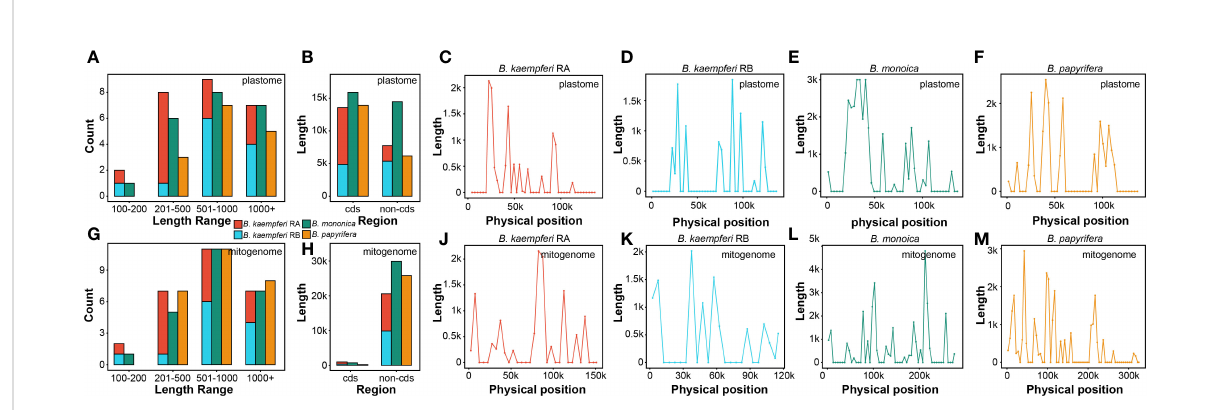
FIGURE 4 Transferred fragments from plastome to mitogenome across the three Broussonetia spp. in this study. (A) Length distribution of transferred fragments in plastome. (B) Type of transferred fragments in plastome. (C) Length distribution of transferred fragments in mitogenome. (D) Type of transferred fragments in mitogenome. (E – H) Location of transferred fragments across plastome. (J – M) Location of transferred fragments across